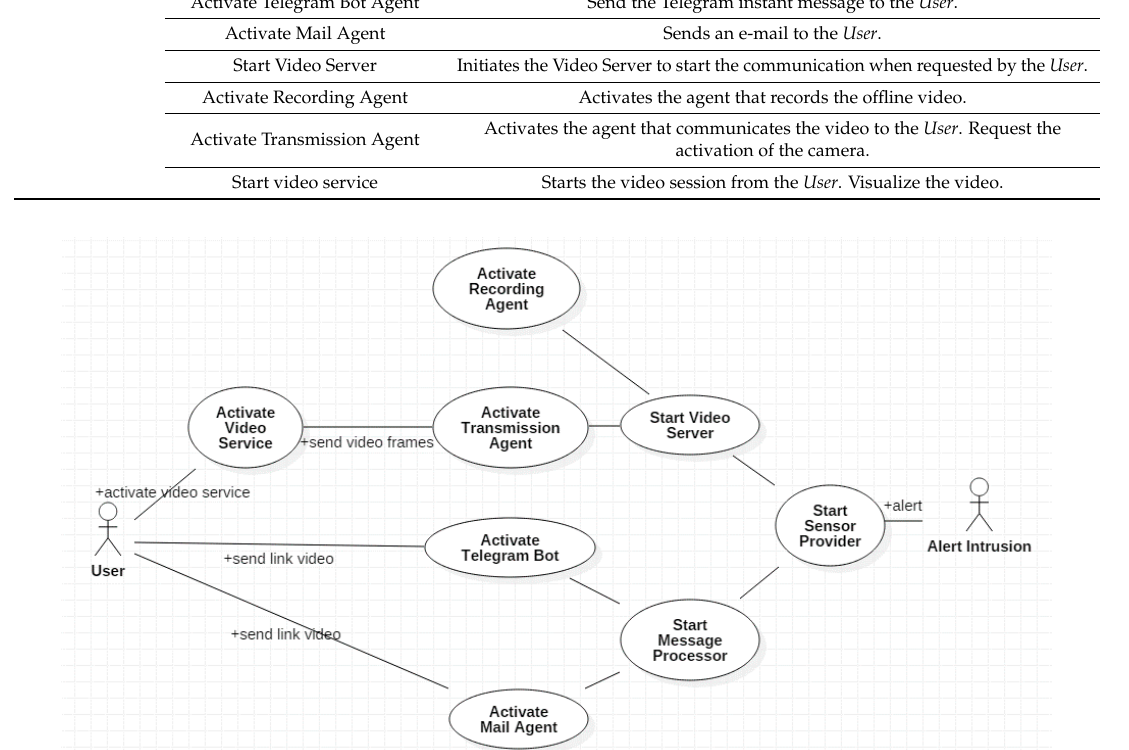
Figure 2. Diagram of actors and use cases of the video surveillance system.